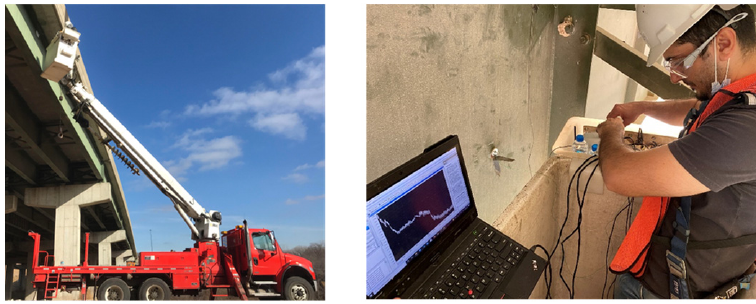
Figure 11. Man-lift truck to access the regions with cracks in the bridge girders.